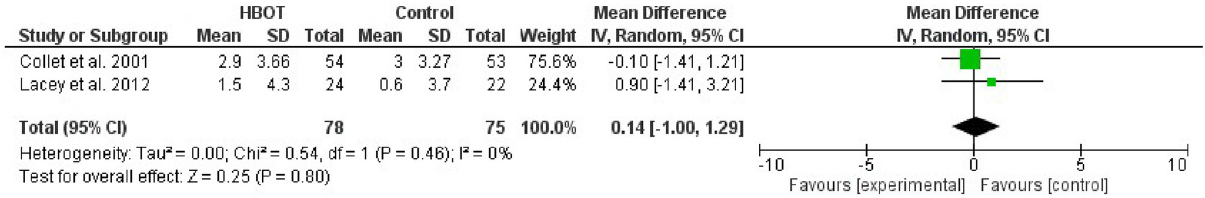
Fig 2. Meta-analysis: Forest-plot of the differences in outcomes for the GMFM score in the selected studies.